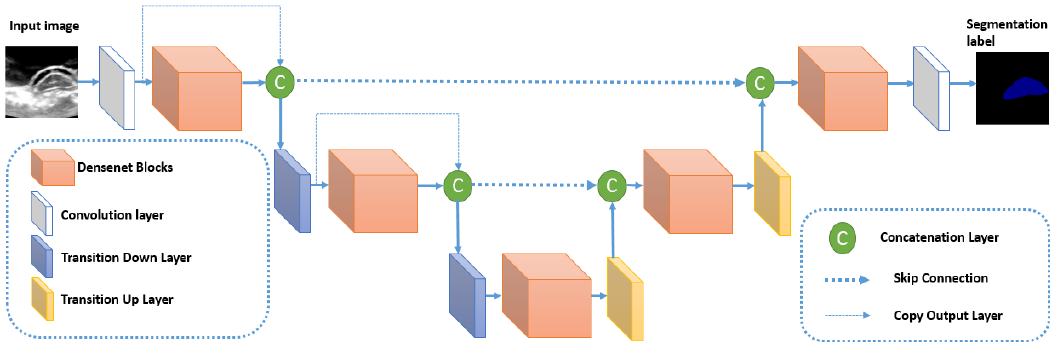
Figure 7. Spinal Cord semantic segmentation using Fully convolutional